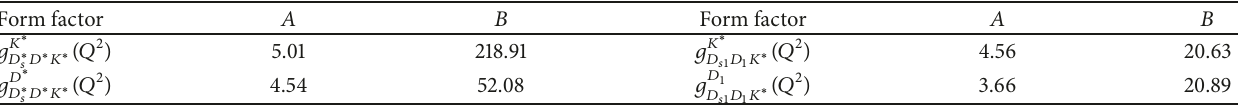
Table 3: Parameters appearing in the fit functions for the 𝑔 퐷 ∗ (𝛿,𝛿 耠 ) = (0.70,0.50)